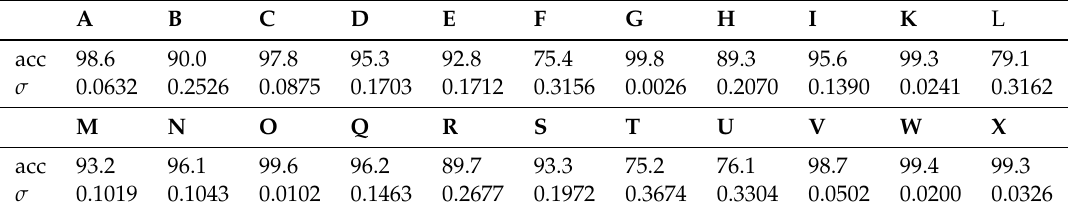
Table 3. Mean accuracy scores (denoted as acc, in %) and standard deviations (denoted as σ ) of all 57-fold cross validation results given for each gesture in the french sign language (LSF) alphabet.